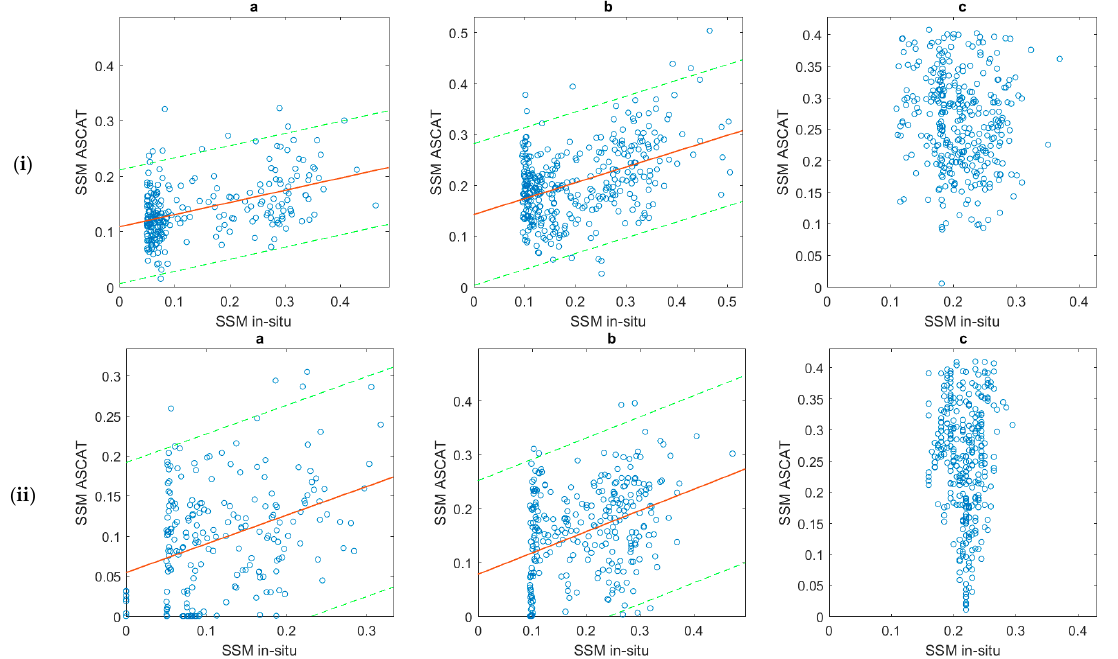
Figure 2. Scatter diagram of in situ and predicted SSM from ASCAT for the different land cover types in EUROPE in ( i ) 2010 and ( ii ) 2011. ( a ) ES_AGU, ( b ) ES_LJU, and ( c ) IT_REN. The green dashed lines represent the 95% confidence level.